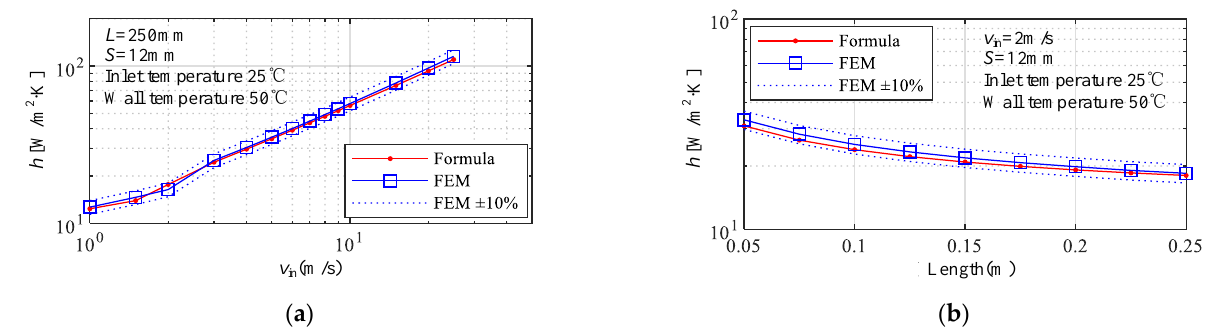
Figure 14. Temperature distribution of the air channel under different wind velocities.